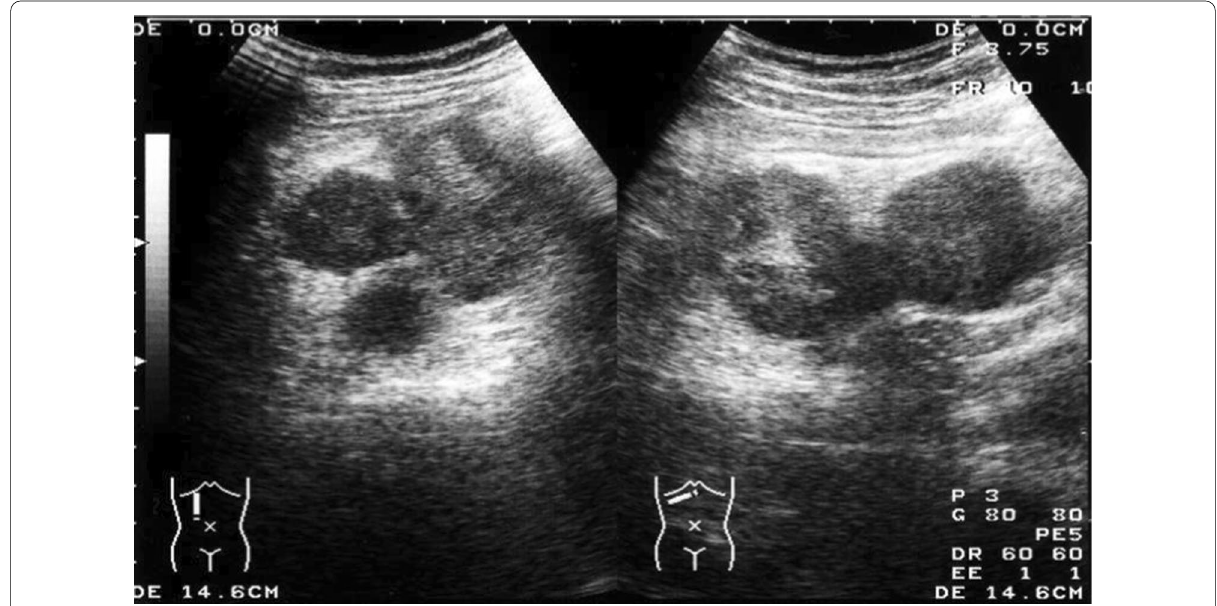
Fig. 1 Ultrasonography showing two heterogeneous echogenic round contiguous masses, 5 cm in size each, at the region of the pancreatic head